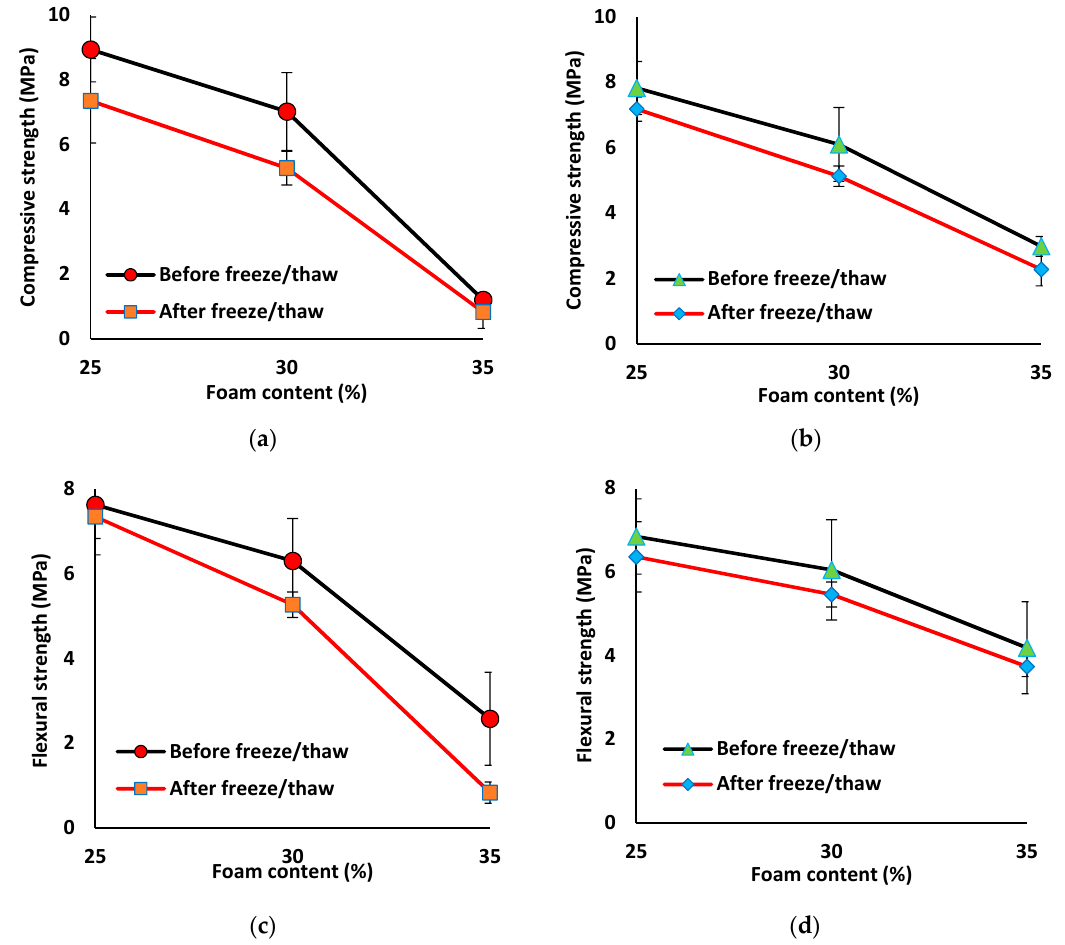
Figure 15. Influences of the freeze/thaw cycles on the compressive strength of mix compositions: ( a ) SW50/GW10; ( b ) SW30/GW30; and on the flexural strength of mix compositions: ( c ) SW50/GW10; ( d ) SW30/GW30.